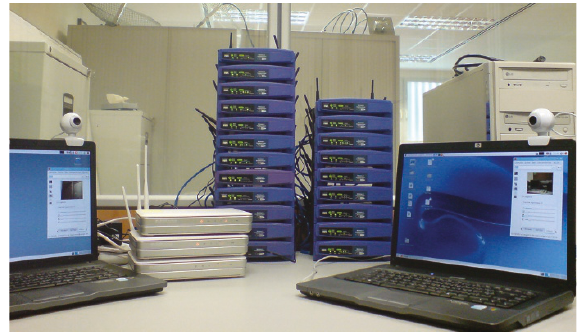
Figure 3: Castadiva ’s physical